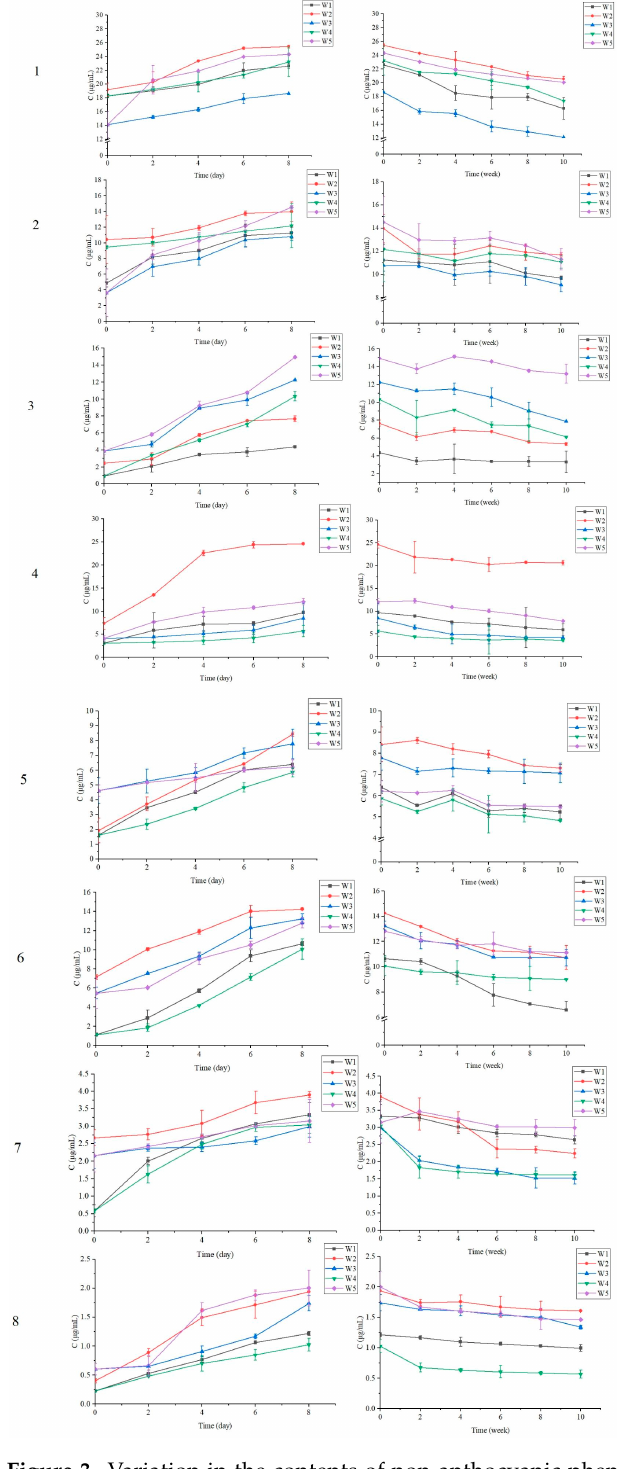
Figure 3. Variation in the contents of non-anthocyanic phenolic compounds in black chokeberry wines during the alcoholic fermentation period (left graph) and maturation period (right